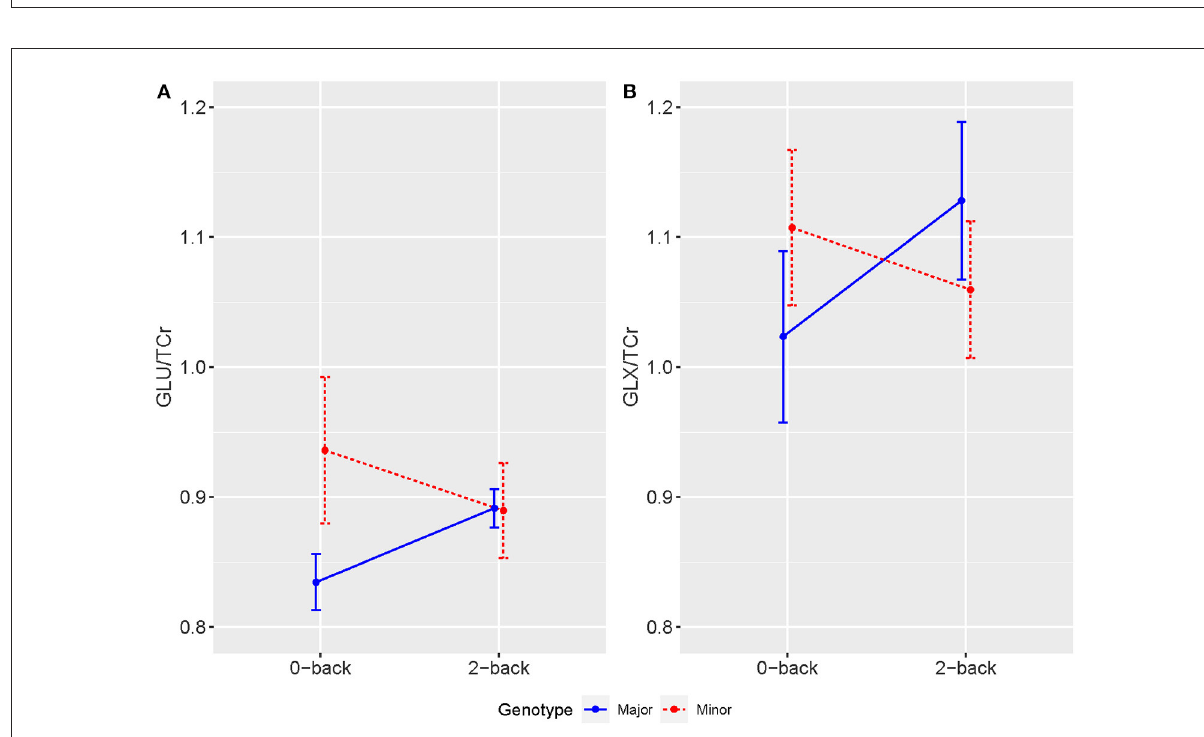
FIGURE4 Averaged levels of (A) Glu/TCr and (B) Glx/TCr in Institutional Units (IU) as measured by 1 H-fMRS across 0-back and 2-back conditions for individuals with SCZ by genotype. Error bars show SEM.